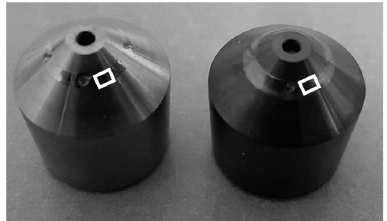
Figure A3. Tested cones: on the left—uncoated cone; on the right—(W ‐ DLC/CrN) ‐ coated cone.